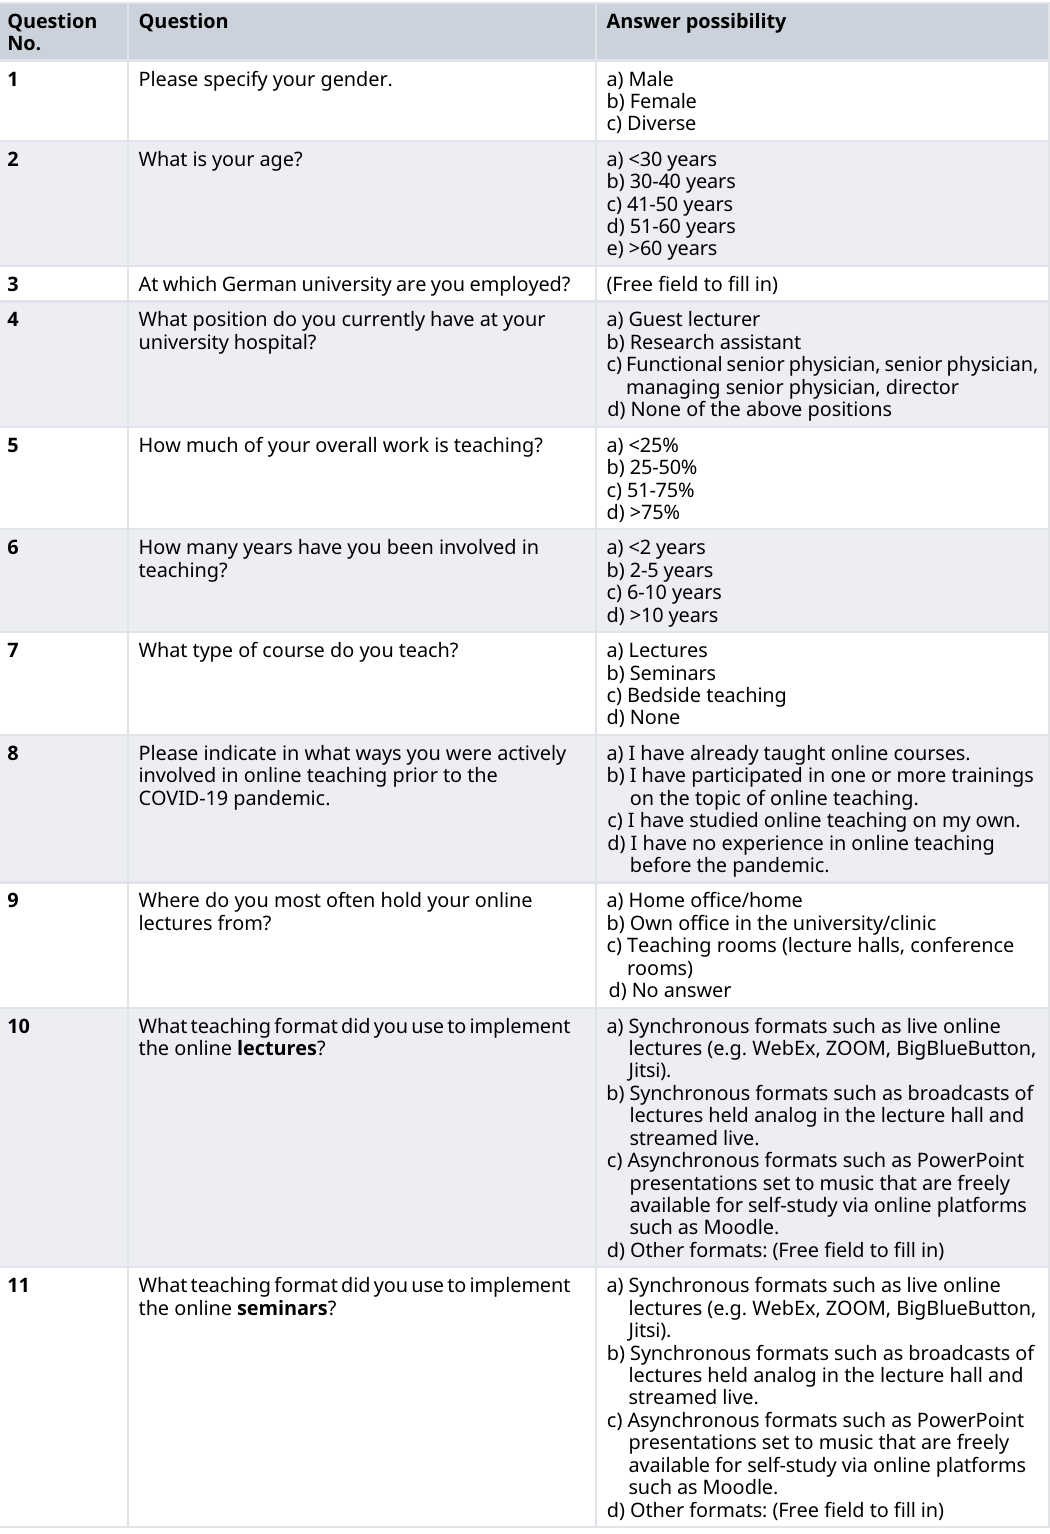
Table 1. Detailed questionnaire